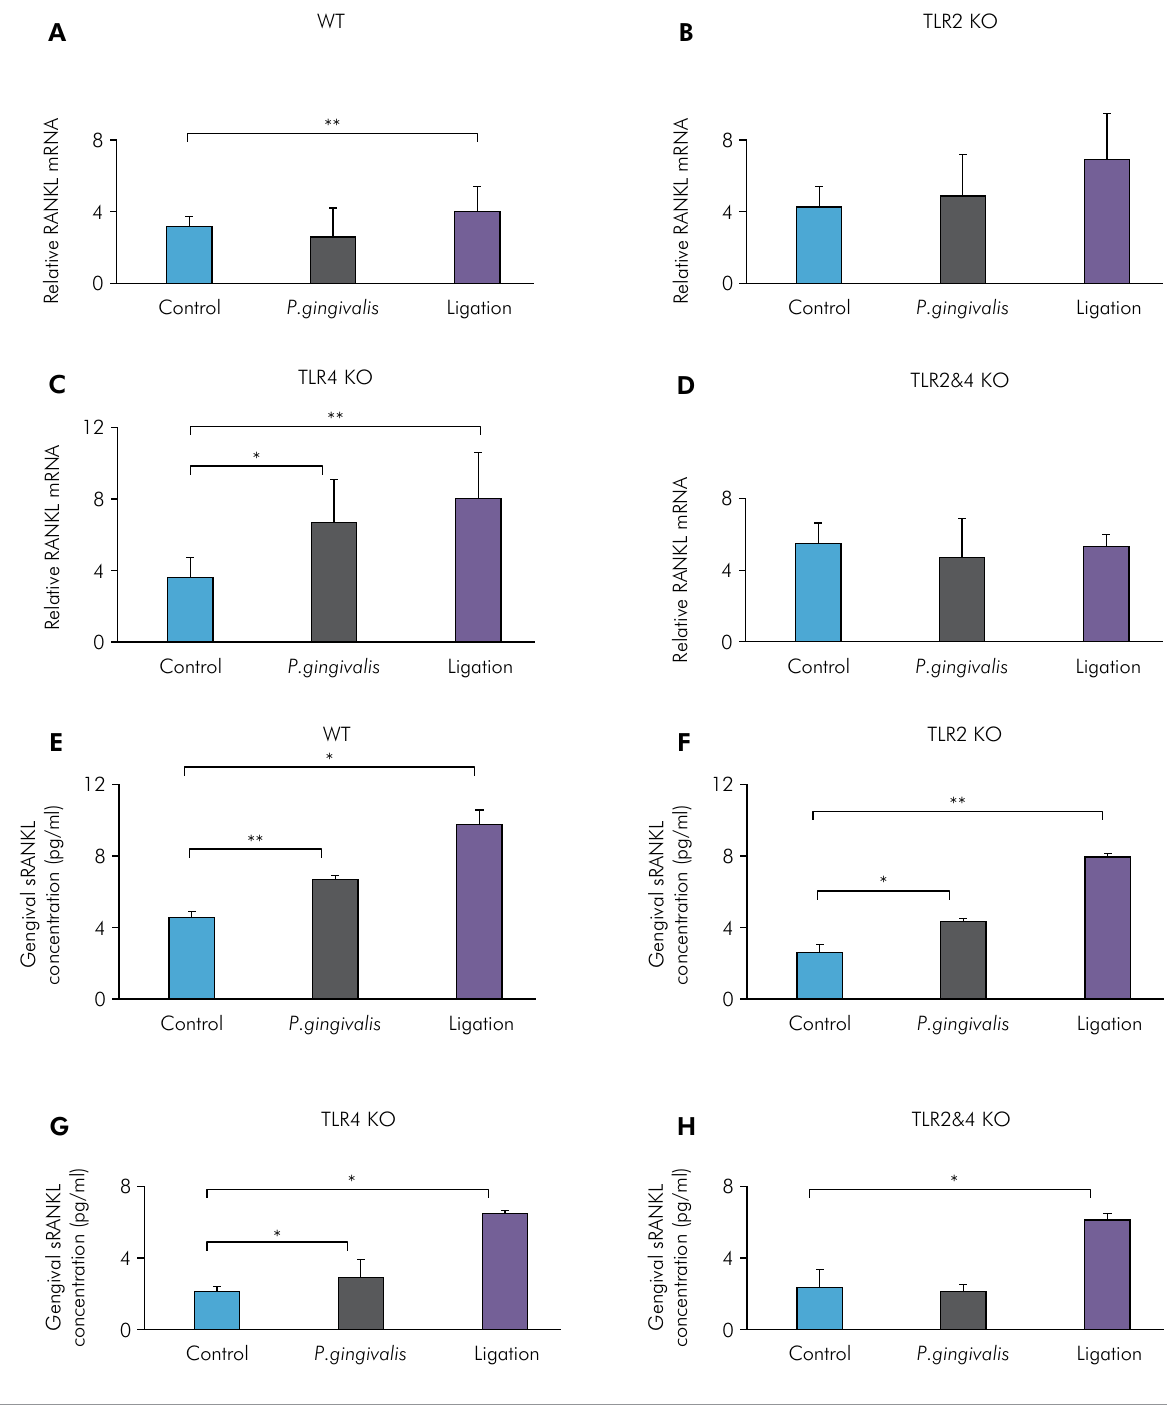
Figure 3. Gingival RANKL mRNA and protein expression levels of P. gingivalis -induced and ligation-induced experimental periodontitis in WT, TLR2 KO, TLR4 KO, and TLR2&4 KO mice. Gingival tissues on the palatal side were collected under a surgical microscope from maxillae and then homogenized for RNA extraction or protein measurement. Gingival RANKL mRNA levels were determined by real-time PCR in the control group, the P. gingivalis infection group, and the ligation group of WT mice (A), TLR2 KO mice (B), TLR4 KO mice (C), and TLR2&4 KO mice (D) (means ± SE, n = 5 mice per group, *p < 0.05, **p < 0.01). Gingival RANKL protein expression levels were measured by ELISA in the control group, the P. gingivalis infection group, and the ligation group of WT mice (E), TLR2 KO mice (F), TLR4 KO mice (G), and TLR2&4 KO mice (H) (means ± SE, n = 5 mice per group, *p < 0.05, ** p <